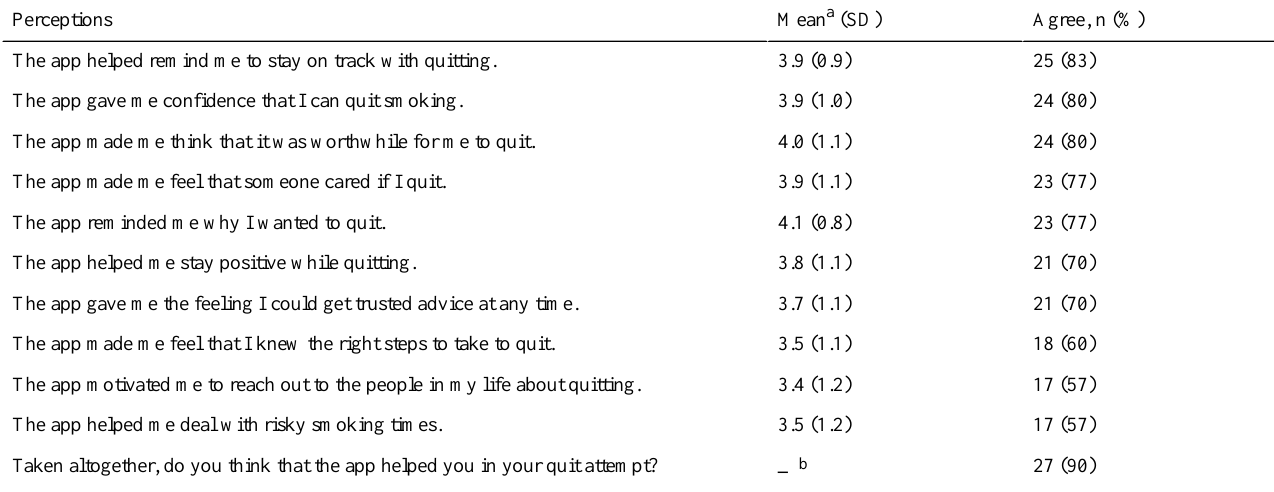
Table 3. Perceptions of how the app might have helped.